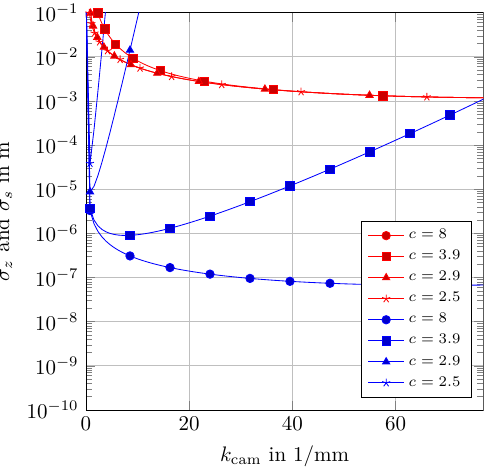
Figure 14. Measurement uncertainty of plenoptic and deflectomet- ric sensor for several surface MTF parameters. The pattern is shown on the surface and also shown on the screen. Both pattern frequen- cies are given relative to the camera sensor image frequencies k cam